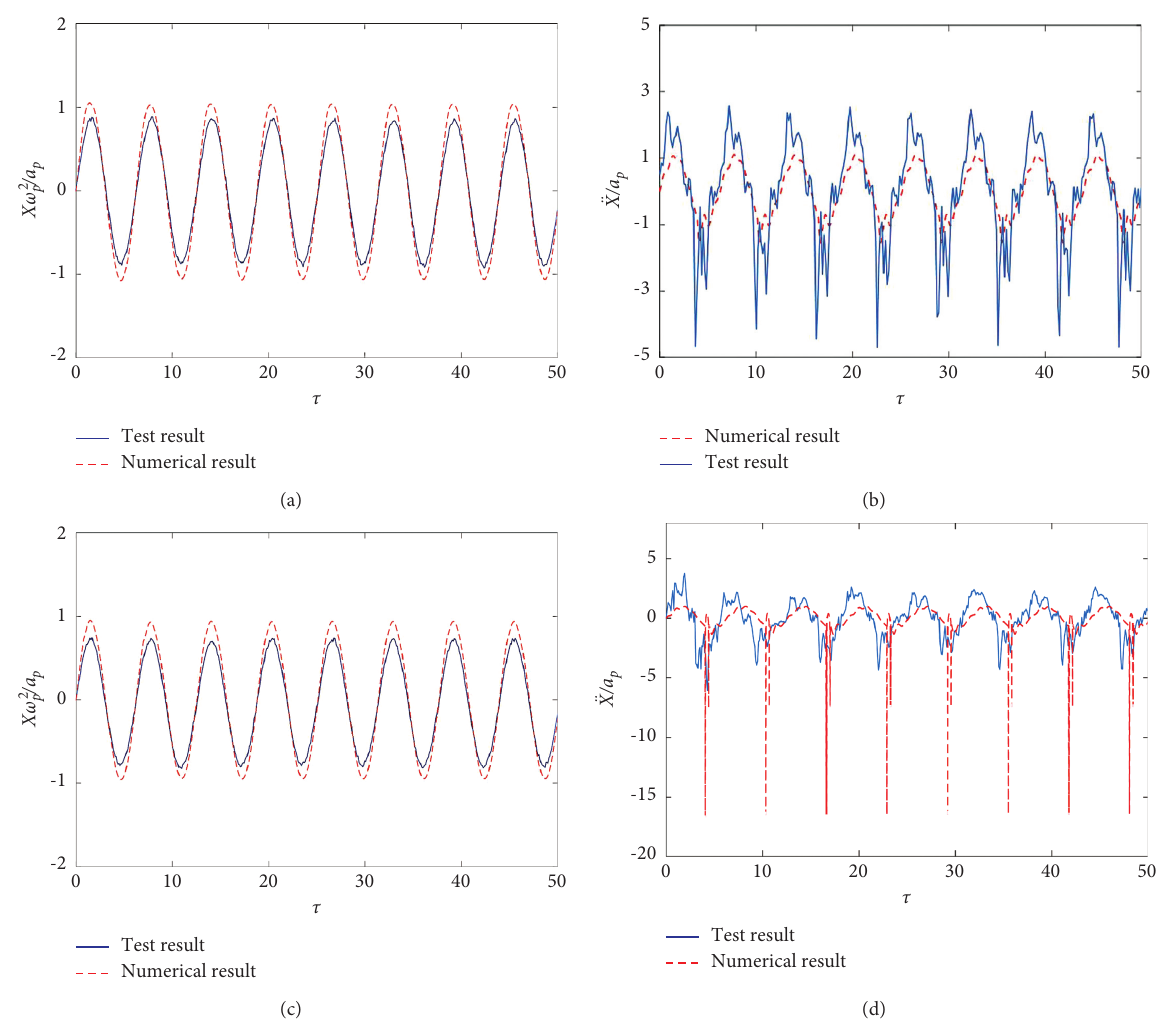
Figure 14: Displacement and acceleration histories of the top and third floors of the four-story steel frame structures with pounding. (a) Dimensionless displacement histories of the top floor. (b) Dimensionless acceleration histories of the top floor. (c) Dimensionless displacement histories of the third floor. (d) Dimensionless acceleration histories of the third